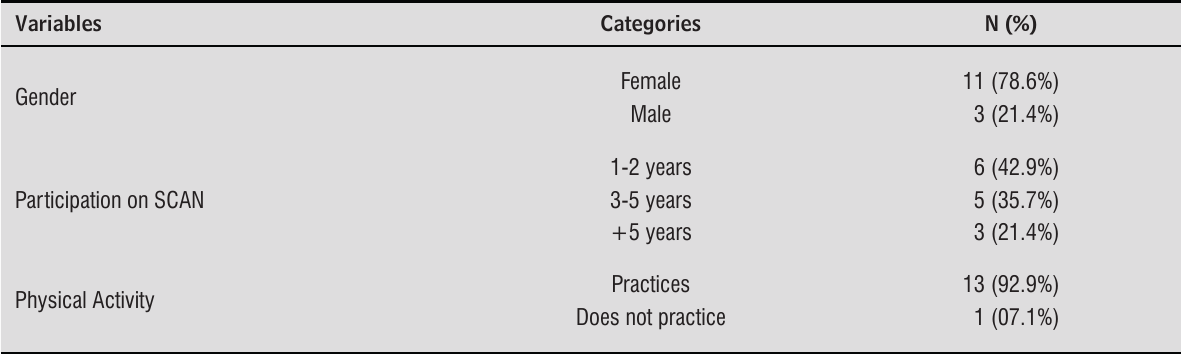
Table 1 - Demographic, social, and lifestyle characteristics of the elderly participating in interaction groups in Caxias do Sul City, RS State, 2011. (N = 14)